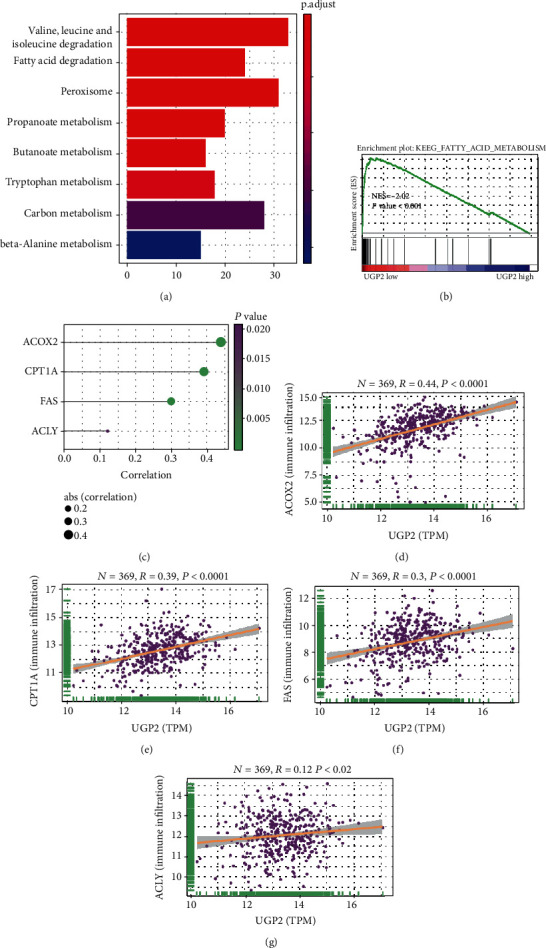
UGP2 has potential roles in fatty acid metabolism. (a) KEGG functional enrichment analysis showing the potential mechanism of UGP2 in HCC. (b) GSEA of the relationship between low UGP2 expression and genes associated with fatty acid metabolism. (c–g) The scatter plots show that UGP2 expression is markedly correlated with genes involved in fatty acid metabolism. UGP2: uridine diphosphate-glucose pyrophosphorylase 2; KEGG: Kyoto Encyclopedia of Genes and Genomes; HCC: hepatocellular carcinoma.